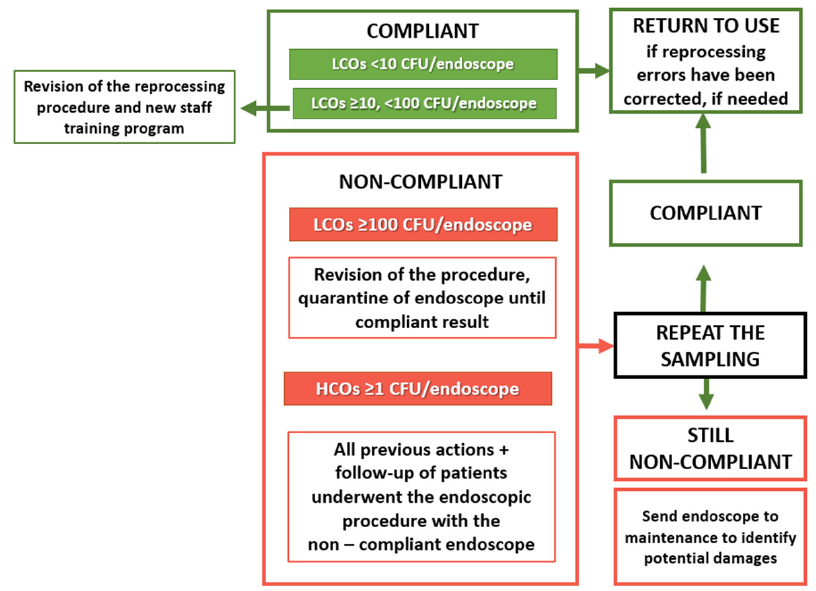
Figure 1. Flowchart of fundamental steps of microbiological surveillance on bronchoscopes to obtain a microbiologically guaranteed and safe device for the patient.